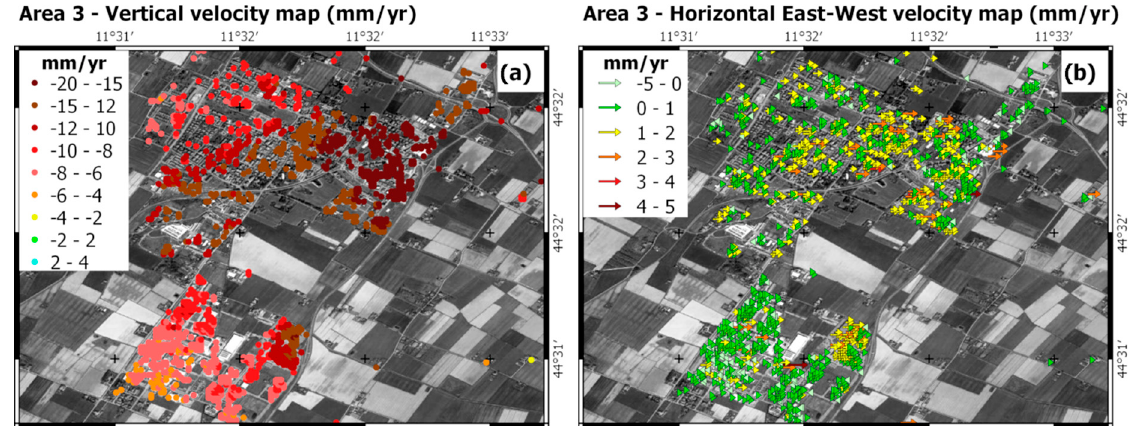
Figure 8. Vertical and horizontal velocity maps (mm/yr) within area 3. Negative vertical rates in ( a ) indicate subsiding phenomena; in ( b ) negative rates indicate West-oriented horizontal displacement, positive rates indicate East-oriented horizontal displacement. Module of horizontal displacements are better described by the use of row instead of points. White dot denotes the main site of industrial activity.